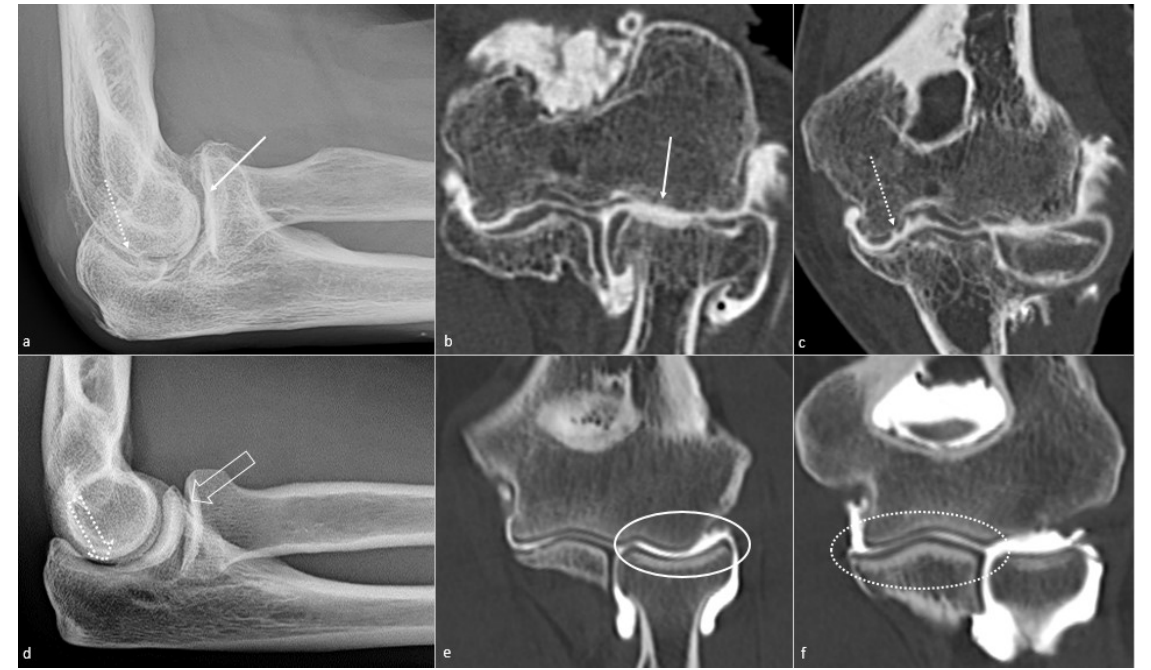
Figure 7. Elbow osteoarthritis. Elbow osteoarthritis in a 57-year-old man suffering from posttraumatic stiffness since she was 12 years old is seen on ( a ) a profile radiograph, with humeroradial (white arrow) and humeroulnar (dotted white arrow) joint space narrowing; humeroradial chondrolysis is depicted on ( b ) a frontal CT-arthrography view (white arrow), and humeroulnar cartilaginous erosions are shown on ( c ) a frontal CT-arthrography view (dotted white arrow). Normal corresponding aspects are shown in ( d ) a profile radiograph, ( e ) a frontal CT-arthrography view of the humeroradial joint (white circle) and ( f ) a frontal CT-arthrography view of the humeroulnar joint (dotted white circle).